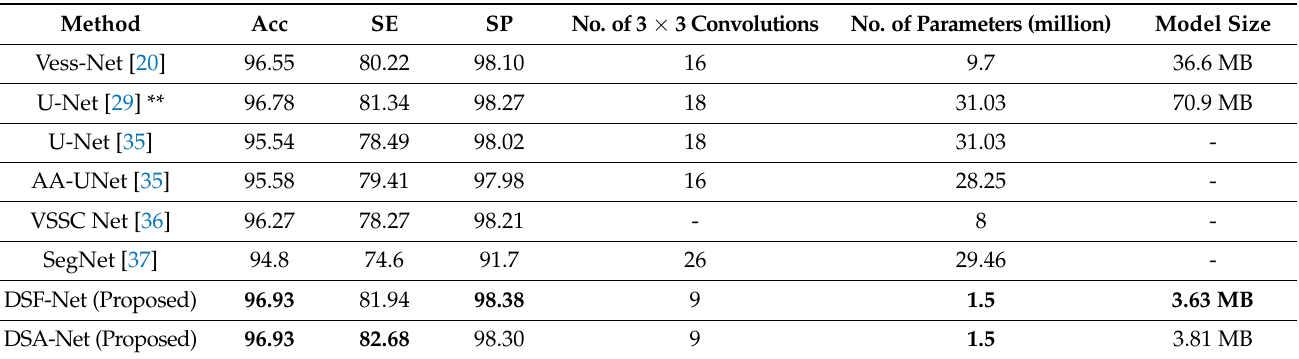
Table 4. Architecture and model comparison of the proposed DSF-Net and DSA-Net with current state-of-the-art schemes for the DRIVE